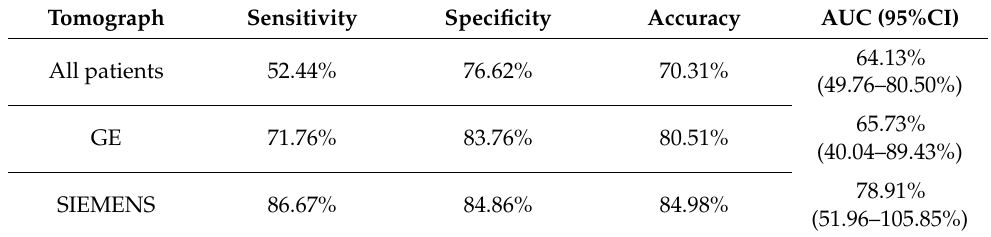
Table 5. Performance values of the predictive model for